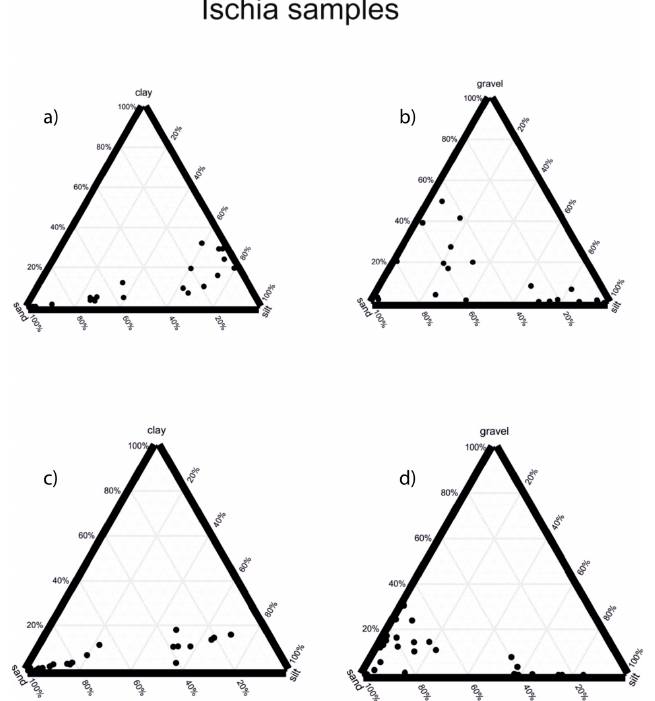
Figure 5. Ternary plots constructed for the Ischia sea bottom samples (modified after Aiello, 2021) [37]. ( a ) ternary plot (clay–sand–silt); ( b ) ternary plot (gravel–sand–silt); ( c ) ternary plot (clay–sand–silt); ( d ) ternary plot (gravel–sand–silt). Quaternary 2021 , 4 , x FOR PEER REVIEW